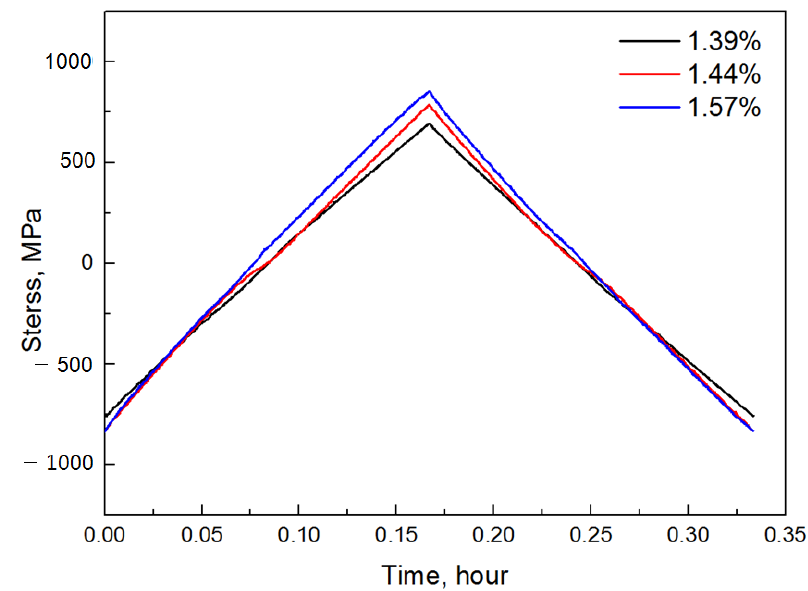
Figure 9. Variation in stress with time at 900 °C. Table 4. Comparison of the coefficient of